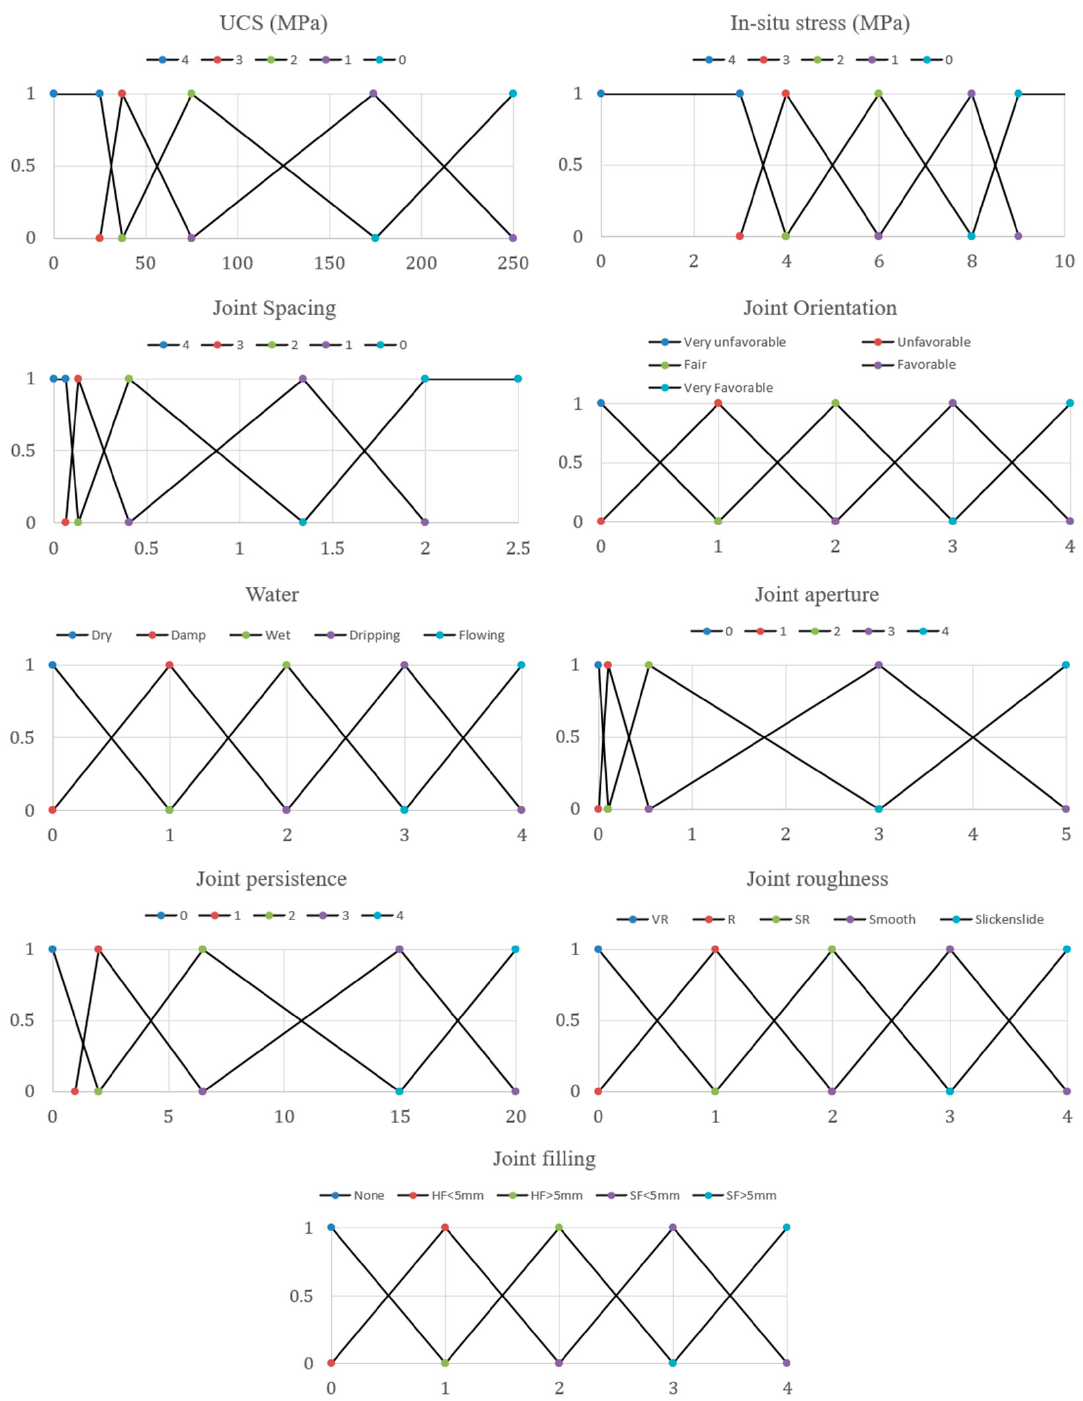
Figure 1. Illustrations of cavability natural factors as input variables (UCS, in situ stress, joint spacing, joint orientation, water, joint aperture, joint persistence, joint roughness, joint filling) membership function for each variable (0: Very Low, 1: Low, 2: Medium, 3: High, 4: Very High).